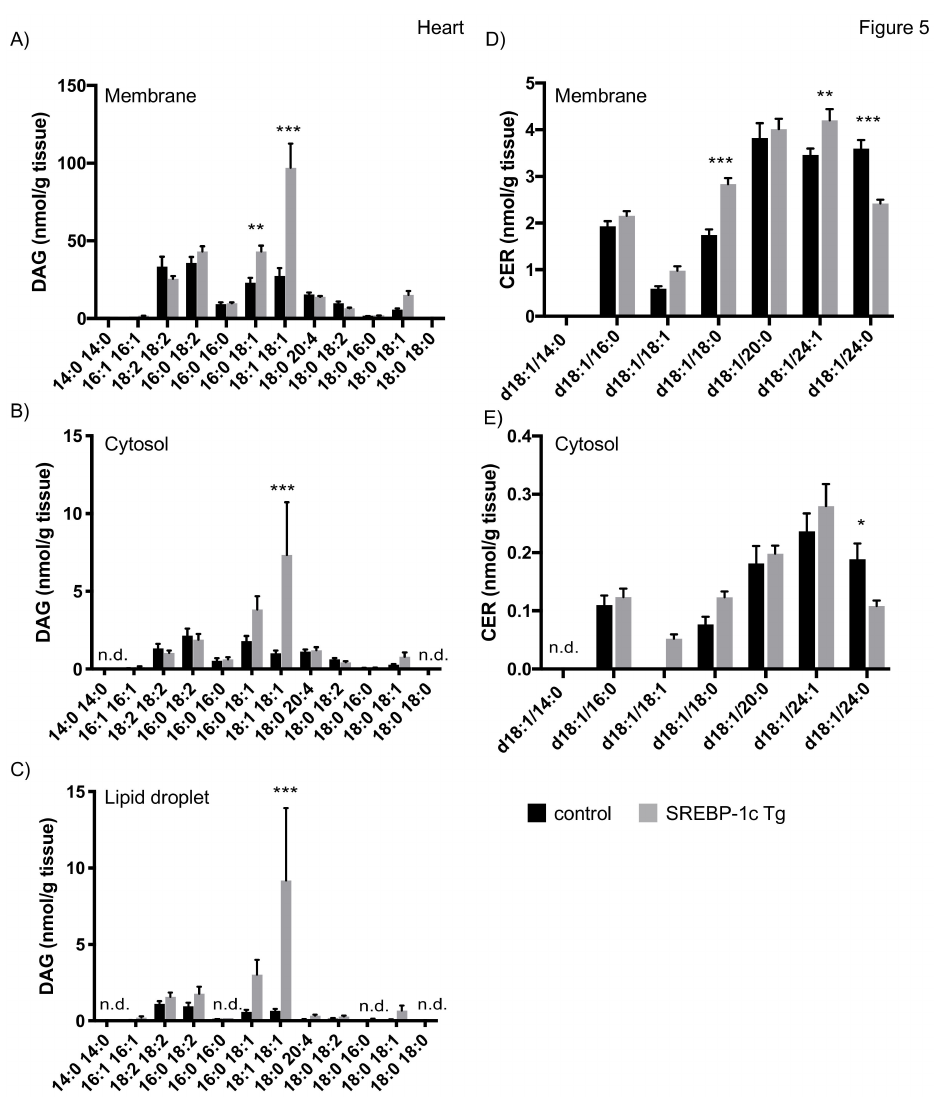
Figure 5. Mass spectrometry analysis of DAGs and CERs in heart tissue fractions. Heart tissue of SREBP-1c adipose-specific overexpressing transgenic (Tg) mice (SREBP-1c Tg) and control mice was subjected to subcellular fractionation. The indicated DAG species were analysed by LC-MS/MS in membrane ( A ), cytosolic ( B ) and LD fraction ( C ). The indicated CER species were analysed in membrane ( D ) and cytosolic fraction ( E ). All data are presented as mean ± SEM (n = 6 per group). n.d., not detected; * p < 0.05, ** p < 0.01, *** p < 0.001; 2-way ANOVA with Bonferroni